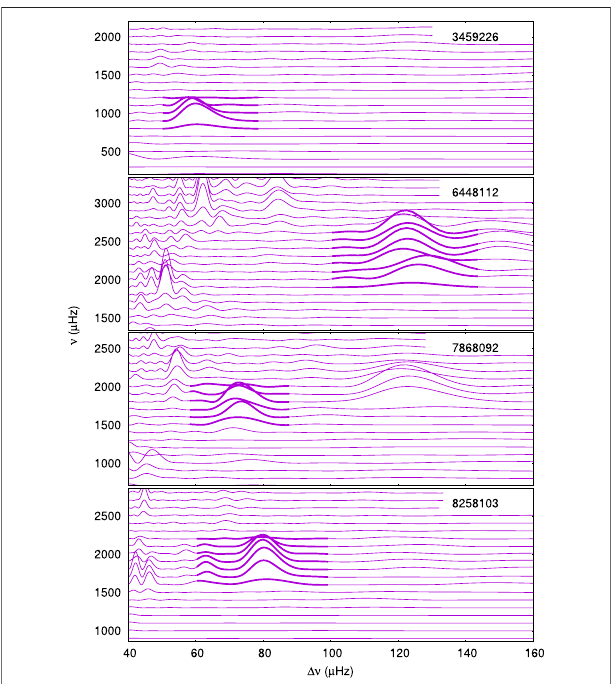
FIGURE 6 | The ] – Δ ] diagrams for the four hottest non-pulsating stars. The thicker solid lines indicate the region which might be a result of solar-like oscillations.